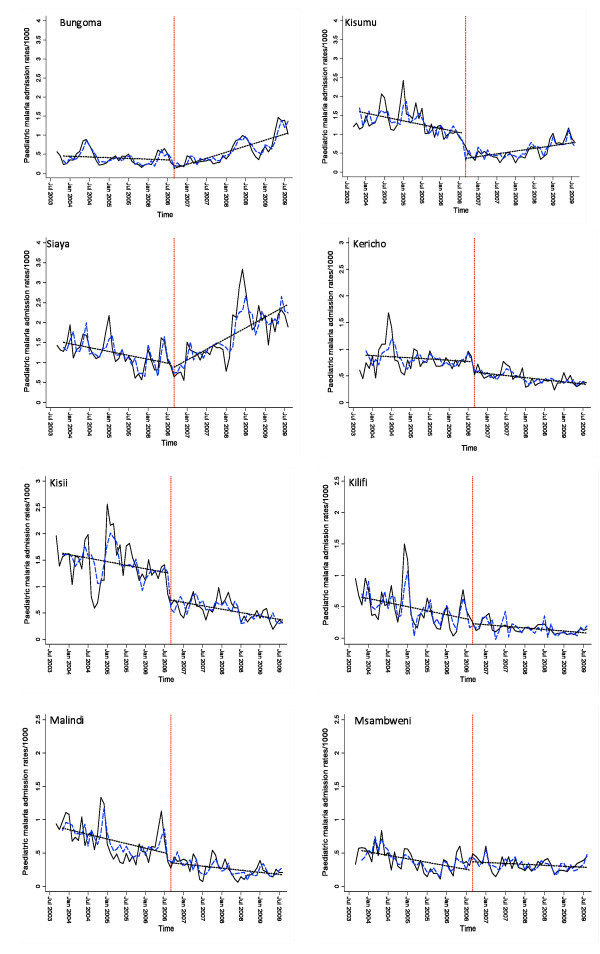
Graph panels show changing paediatric hospitalizations rates due to malaria per 1 000 children 0-14 years before and after scaling up of interventions. The data represents paediatric malaria admission rates by month (black solid line); model predictions of paediatric malaria hospitalization rates controlling for non-malaria case rates, rainfall and controlling for autoregressive and moving average effects (dashed blue line). Fitted lines illustrate the linear trends from model predictions (dashed line) for each segment of the period separated by a break point (red dashed vertical line).